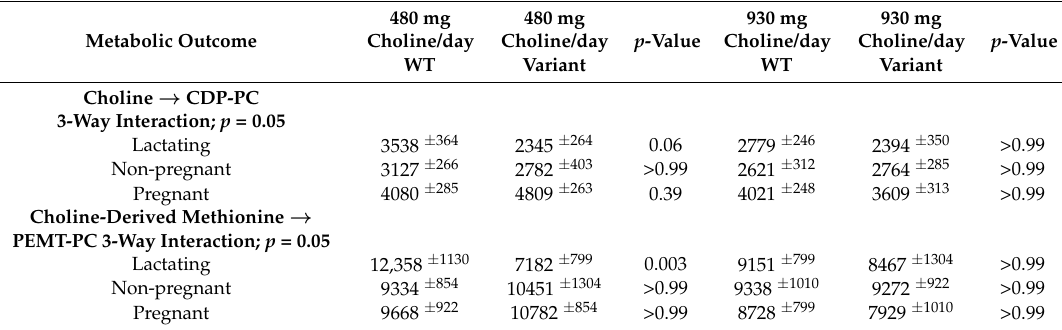
Table 7. CHDH rs12676 genotype alters the metabolic flux of plasma choline metabolites. Values are least-squared means ± standard errors. Choline → CDP-PC and choline-derived methionine → PEMT-PC values are in µ M PEMT-PC/study period. p -values represent the highest order interaction or main effect and pairwise comparisons between genotypes within intake